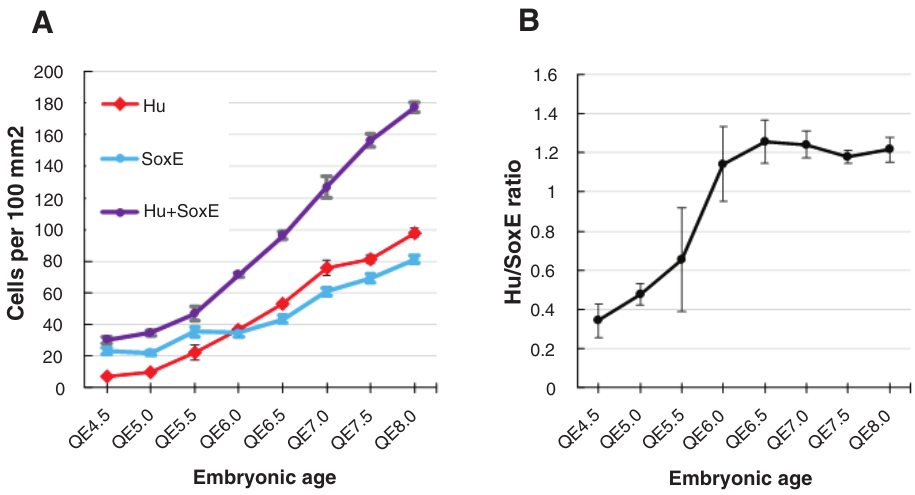
Figure 1. The density of neurons and ENC cells increases in the quail embryo midgut myenteric plexus, but the ratio stabilises. A . The density (number per 100×100 μm area) of neurons (Hu; red), ENC cells (SoxE; blue) and total ENS cells (Hu plus SoxE; purple) increases from QE4.5 to QE8. B . The ratio of neurons to ENC cells stabilises by E6. Error bar=SEM.